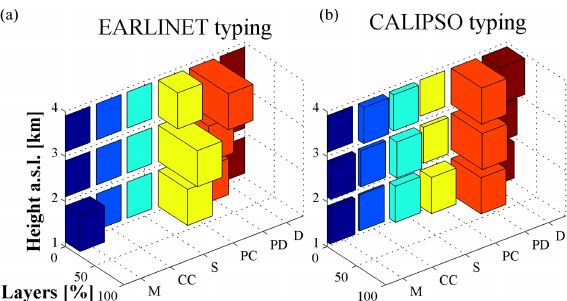
Figure 6. Évora: (a) EARLINET and (b) CALIPSO typing bar- plots for 1km range increment. M stands for marine, D for dust, PC for polluted continental, CC for clean continental, PD for pol- luted dust, and S for smoke subtype.